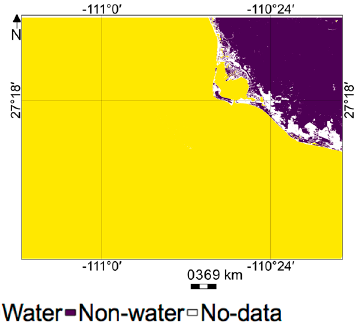
Figure B1. An example of a ground truth from Gulf of California region. Figure A1. An example of a ground truth from Gulf of California